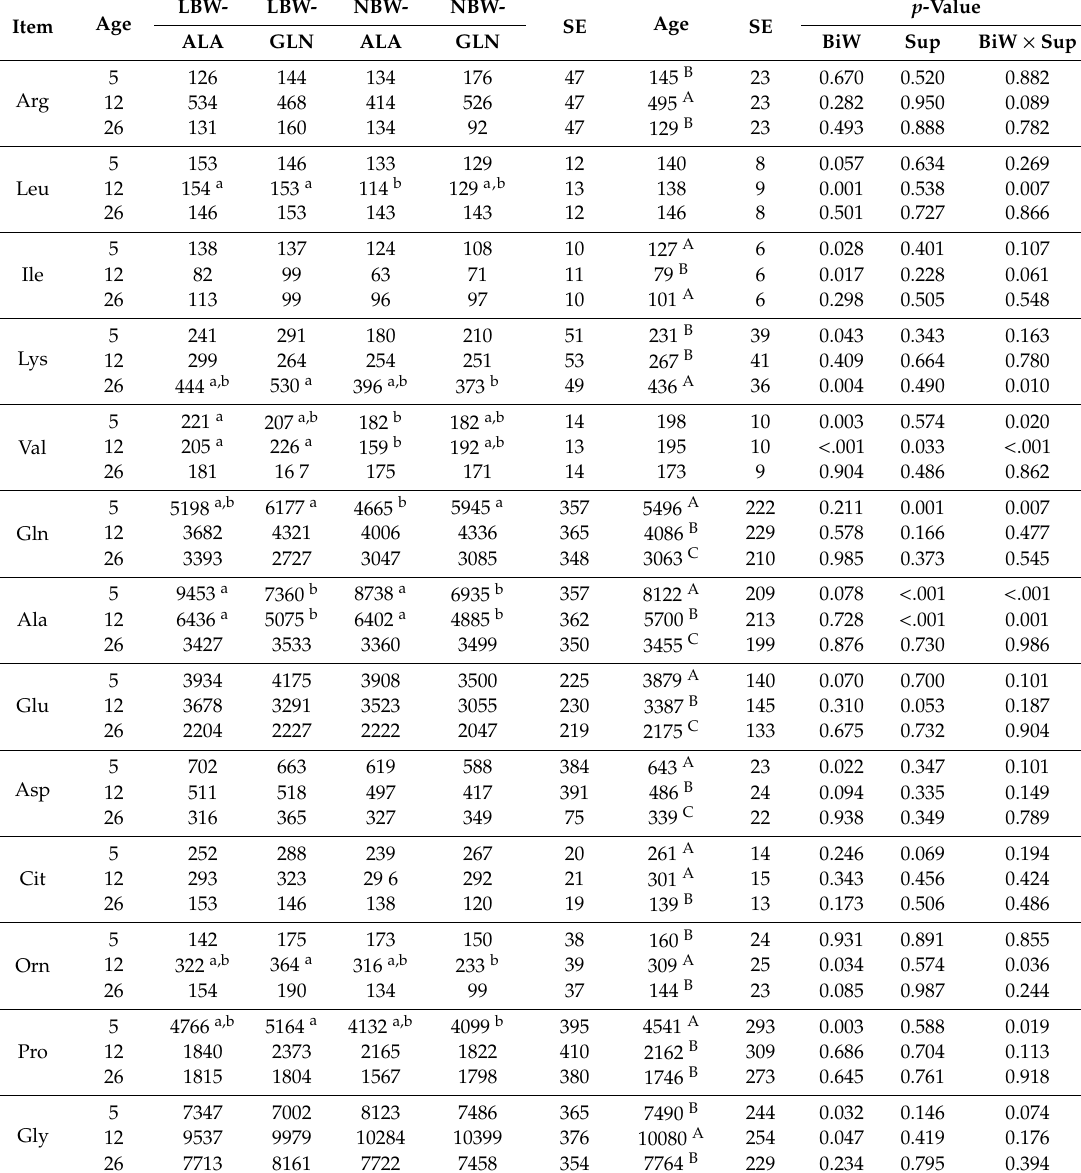
Table 1. Concentrations of intramuscular free amino acids and their metabolites ( µ mol / kg fresh weight) within M. longissimus of low (LBW) and normal birth weight (NBW) piglets supplemented with glutamine (GLN) or alanine (ALA) between 1 and 12 dpn ( n = 12 per group and